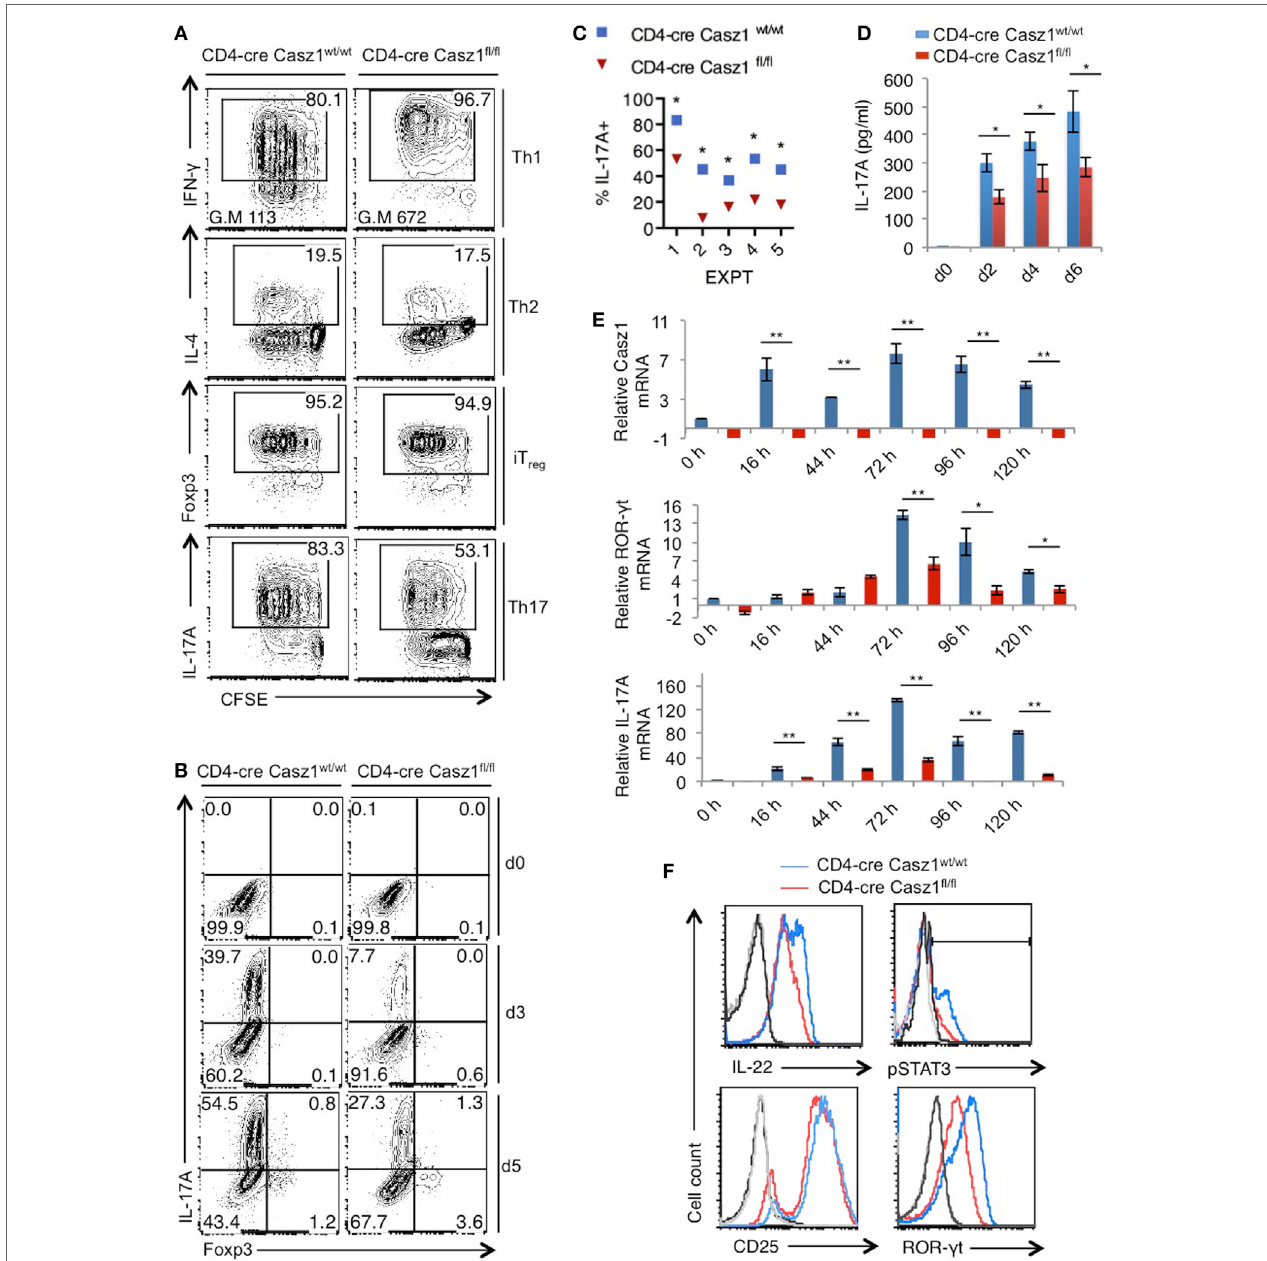
FigUre 3 | Casz1 promotes IL-17A expression in Th17 cultures. (a) Casz1 + / + WT or Casz1 knockout naïve CD4 + T cells were cultured under Th1 (top), Th2 (second panel), iT reg (third panel), or Th17 (bottom panel) conditions for 5 days. Th1, Th2, Th17 cells were stimulated with antigen presenting cells (APC), and iT regs without APC (Figure S6 in Supplementary Material). Intracellular cytokine staining was performed in PMA/ionomycin re-stimulated cells. Data from flow cytometric analyses (gated on CD4 + cells) showing the proliferation (carboxy-fluorescein-succinimidyl-ester, X axis), percentage of IFN- γ (top), IL-4 (second panel), Foxp3 (third panel), and IL-17A (bottom panel) positive cells (Y-axis). Gates were drawn based on unstained and un-stimulated controls (not shown). G.M of IFN- γ staining in Th1 cells (top panel) is indicated at the bottom of the plots. (B) Casz1 + / + WT or Casz1 knockout naïve CD4 + cells were stimulated under Th17 skewing conditions in the presence of APC for indicated days before flow cytometry. (c) Casz1 + / + WT (blue) or Casz1 knockout (red) naïve CD4 + cells were stimulated under Th17 conditions as in ( B ) in five independent experiments, and the frequency of IL-17A + cells was determined by flow cytometry on day 4 (* P < 0.05 was determined by Wilcoxon matched-pairs signed rank test). (D) Supernatants were collected for enzyme linked immunosorbent assay at indicated time-points. (e) Casz1 + / + WT (blue) or Casz1 knockout (red) naïve CD4 + cells were stimulated under Th17 conditions for indicated time-points as in (B) , and APCs were removed by MACS before determining the mRNA levels of Casz1 (top), RAR-related orphan receptor- γ t (middle), and IL-17A (bottom) in CD4 + T cells by qPCR. (F) Casz1 + / + WT (blue) or Casz1 knockout (red) cells were stimulated as in (B) for 3 days and were stained for indicated proteins (gated on CD4 + cells). For phosphorylated STAT-3 (pSTAT3) and pSTAT5 staining, cells were washed and re-stimulated with IL-6 or IL-2, respectively for 30 min before fixation. The results are representative of at least three independent experiments (* P < 0.05, as determined by unpaired Student’s t -test or Mann–Whitney test). Gates were drawn using unstain or isotype